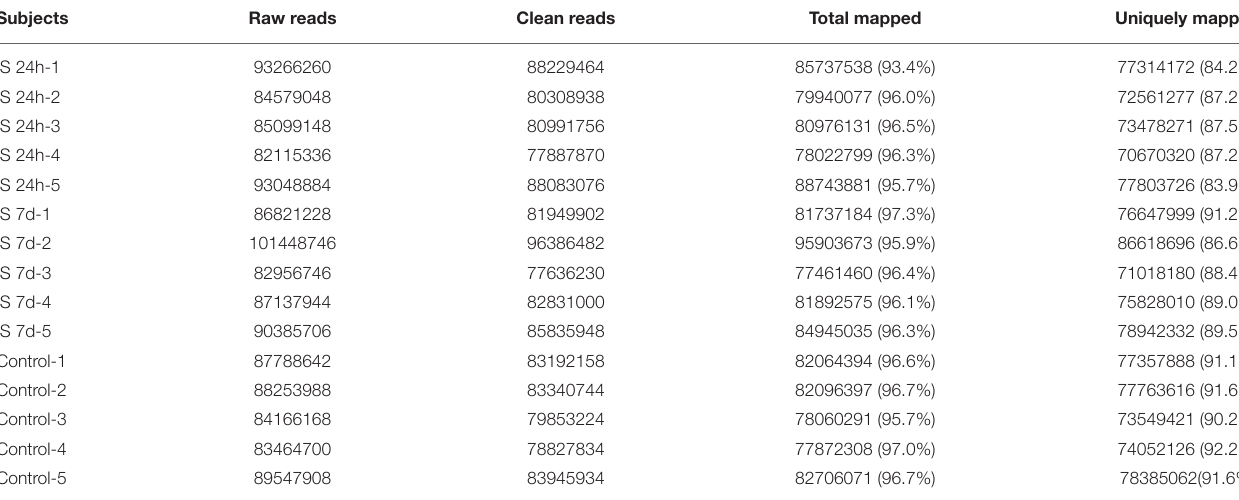
TABLE 3 | Summary of sequence reads mapping to